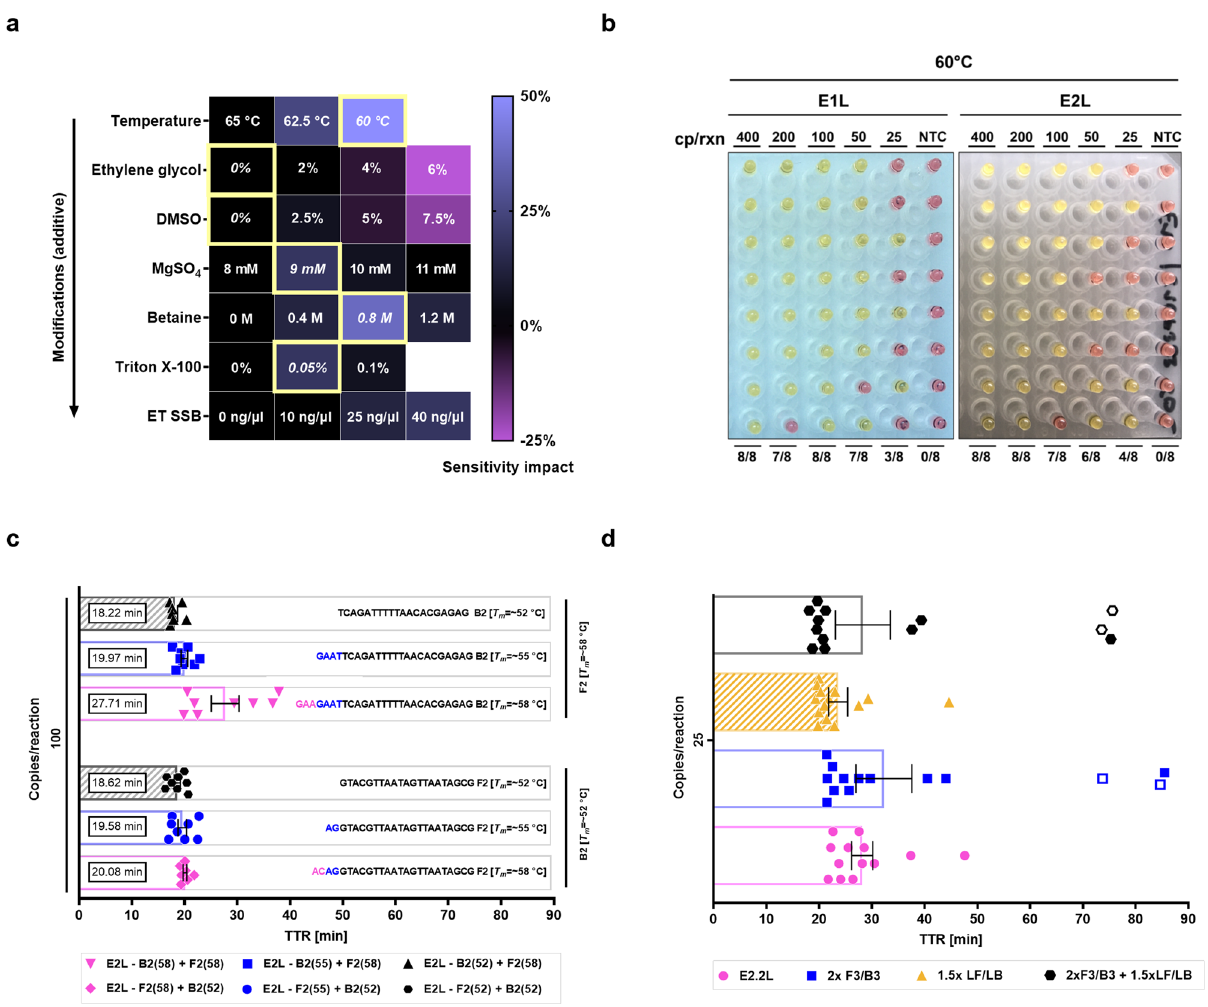
Fig. 2 Reaction optimization and primer set modi fi cation for the detection of SARS-CoV-2 E gene. a Heat map showing the impact of master mix modi fi cations on reaction sensitivity with the E2L primer set. The sensitivity impact represents the change in reaction sensitivity, which was evaluated as percent change in ampli fi cation success rate at 25 copies/reaction with 16 replicates per condition. All reactions were run for 60 min. Rectangles highlighted in yellow show parameters carried over to the next phase of testing; therefore, modi fi cations are additive going from top to bottom. b Comparison of E1L and E2L primer set sensitivity at 60 °C measured as number of positive replicates. All reactions were run for 60 min and were evaluated by colorimetric change only. c Effect of T m of F2/B2 priming regions in FIP/BIP primers on the performance of the E2L primer set. Primers were adjusted by adding or removing complementary bases towards the 5 ’ end of F2 or B2 priming regions in such a way that the T m differential between 2 sequential variants was ~3 °C (as predicted by PrimerExplorer V5). The best performing priming regions have patterned bars. d Outcome of increased auxiliary primer concentrations. The graph shows identical reactions differing only in the concentration of outer primers (F3/B3), loop primers (LF/LB), or both. The best performing modi fi cation has a patterned bar. Open symbols represent non-speci fi c products, whereas closed symbols are speci fi c as determined by melt curve analysis of ampli fi cation products. The highest time to reaction value on x-axis signi fi es the total duration of the reaction. For NTC reactions, PCR-grade water was used as the input. All experiments in a were performed using “ NEB WarmStart ” reaction mix with additional speci fi ed additives while for b – d “ NEB WarmStart 1.1 ” reaction mix was used. Error bars represent standard error of the mean. In all experiments, n = 8 technical replicates per group were used. TTR time to reaction, NTC no-template control, ET SSB extremely thermostable DNA-binding protein, cp/rxn copies per